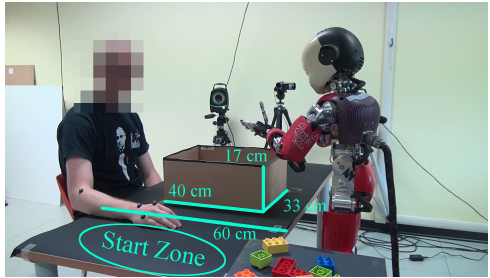
Figure 1: Setup of the experiment. Blocks are passed by an experi- menter in the start zone to both the participant and the robot at the same time. Their goal is to drop these blocks in the box. The picture is a snapshot of the “one box”